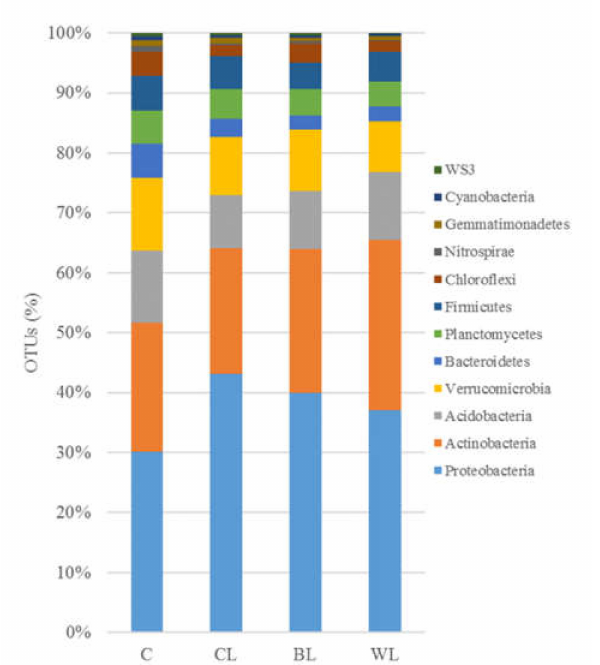
Figure 3. Relative abundances of phyla in the control and grease-spiked soil microbiomes (mean val- ues, n = 3). Relative abundances are based on the proportional frequencies of OTUs that could be